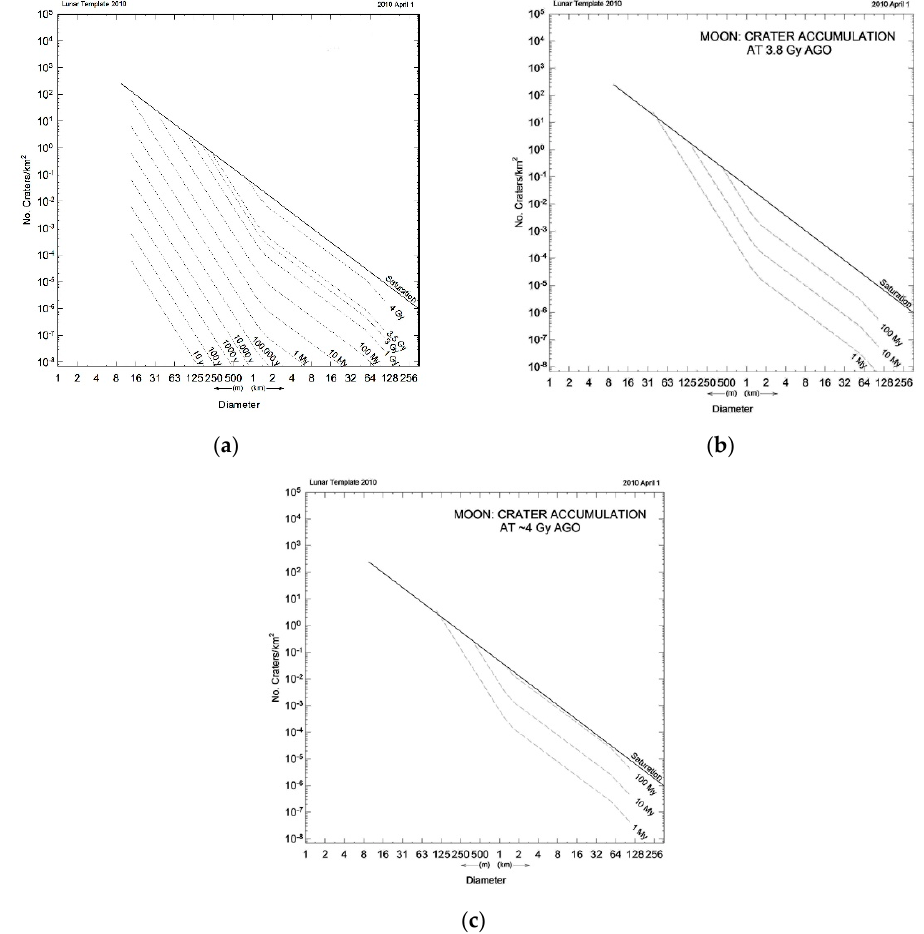
Figure 14. ( a ) A 2010 iteration of lunar isochron diagram, plotting crater density (craters/km 2 ) versus age of a given surface. Diagonal line at the top shows the empirically measured saturation equilibrium crater densities in the Solar System (based on Hartmann (1984 [19])); maximum crater densities oscillate by a factor ~2 around this line. ( b ) Isochron diagram as plotted for conditions ~3.8 Ga ago, using the cratering rate ~10 2 times the present rate. Such a cratering rate has been measured at that time from crater counts at dated Apollo landing sites (see Neukum et al. (2001, [38])). Cratering rates were declining half-life of roughly 10 2 years, so that the 100 Ma isochron has the most relevance, showing that craters of diameter ~500 m to ~1 km would reach saturation during a ~100 Ma interval at that time, producing a regolith many tens of meters deep. ( c ) Same as ( b ) but plotted for conditions ~4.1 Ga (or more?) ago, using cratering rate ~10 3 times the present rate, which may have existed then, according to the “accretion tail” model of declining flux before 4.0 Ga ago. This diagram illustrates, at least schematically, how bombardment at ≳ 10 3 times the current rate, causes saturation simultaneously at crater diameters >2 km within ~100 Ma, causing explosive growth of kilometers-deep megaregolith during such early conditions.